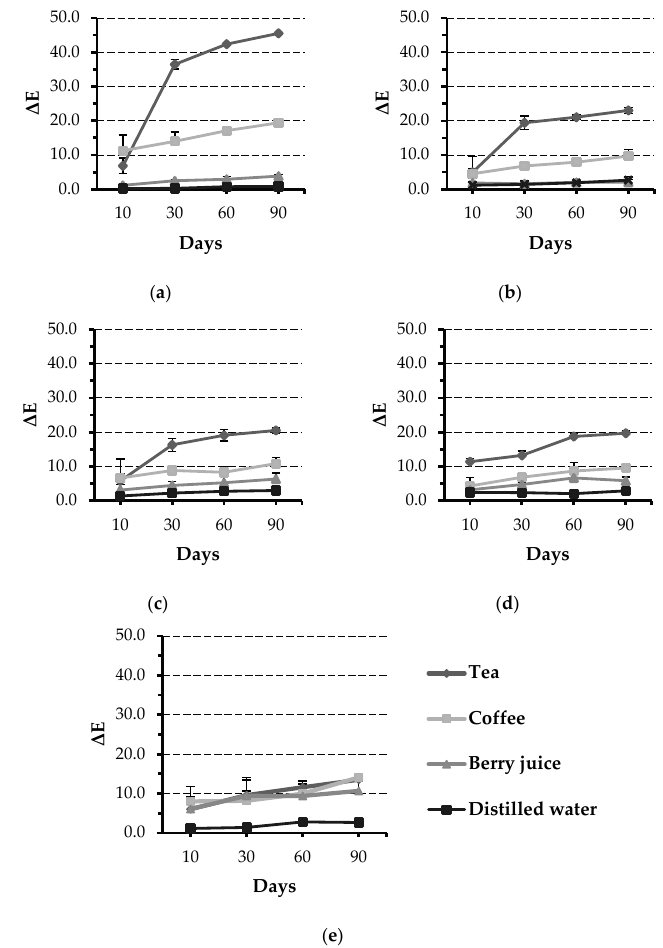
Figure 2. Line graphs showing Δ E values for the five tested materials after immersion in different solutions for 10, 30, 60, and 90 days: ( a ) Filtek Z350, ( b ) Filtek Bulk-Fill, ( c ) Tetric N-Ceram Bulk-Fill, ( d ) Sonic Fill 2, and ( e ) SDR. Error bars represent standard error.